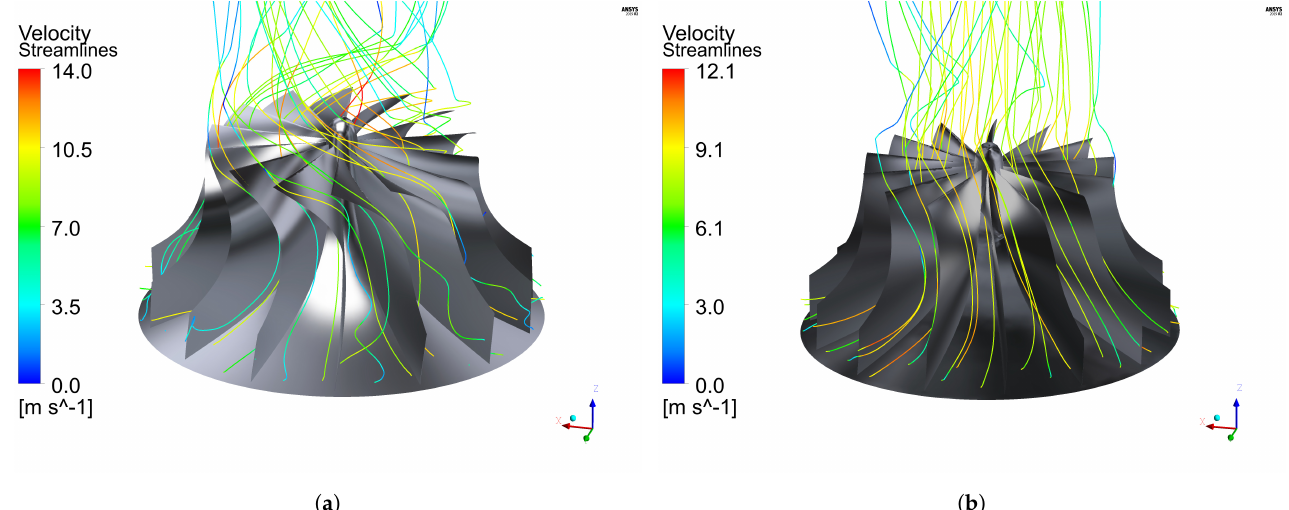
Figure 10. Streamlines in rotating co-ordinates for the first and third designs. Direction of rotation—counterclockwise. ( a ) Streamlines for the first design; ( b ) streamlines for the third